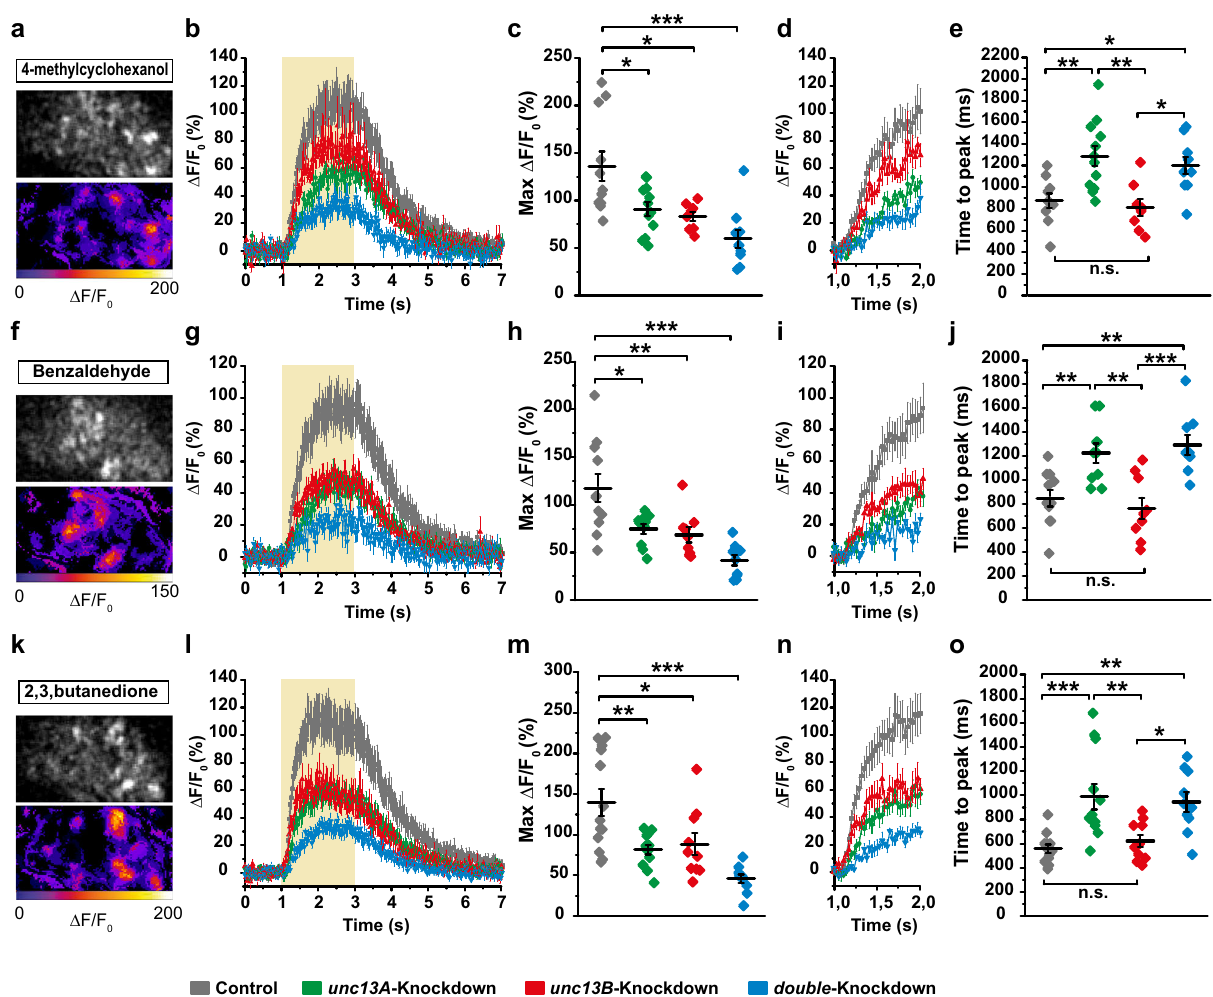
Fig. 3 Both, Unc13A and Unc13B, speci fi cally contribute to synaptic transmission from ePN output synapses. a – o In vivo calcium imaging of homer- GCaMP3 using two-photon microscopy at postsynaptic terminals of MB Kenyon cells in the calyx upon odor stimulation, 4-methylcyclohexanol ( a – e ), benzaldehyde ( f – j ) and 2, 3-butanedione ( k – o ). a , f , k Representative false color-coded two-photon images of odor-induced fl uorescence changes of GCaMP3 in MB calyx (mb247: homer-GCaMP3) at the dendritic terminals of Kenyon cells. b , g , l Odor-induced fl uorescence change ( Δ F / F 0 %) of homer- GCaMP3 in animals expressing UAS: unc13A-RNAi ( unc13A -knockdown, green traces) or UAS: unc13B-RNAi ( unc13B -knockdown, red traces) or both (double-knockdown, blue traces) under control of GH146-Gal4 was compared with the control group ( GH146-Gal4/ + ; mb247: homer-GCaMP3/ + , gray traces). c , h , m Maximum fl uorescence changes of GCaMP3 (Max Δ F / F 0 %) upon odor stimulation. The Max Δ F / F 0 (%) in unc13A -knockdown (green), unc13B -knockdown (red) and double-knockdown (blue) shows a signi fi cant reduction compared to the control group (gray). d , i , n The Δ F / F 0 (%) traces of the fi rst second of odor stimulation for 4-methylcyclohexanol ( d ) benzaldehyde ( i ), and 2, 3-butanedione ( n ). e , j , o Time to maximum fl uorescence changes of GCaMP3 (time to peak) upon odor stimulation. The time to peak (ms) is signi fi cantly increased in unc13A -knockdown (green) and double- knockdown (blue) groups compared with the control group while no change was observed for unc13B -knockdown group (red). Values represent mean ± SEM. Control group: n = 11, unc13A -knockdown: n = 12, unc13B -knockdown: n = 8, double-knockdown: n = 10 ( b – e ). Control group: n = 11, unc13A